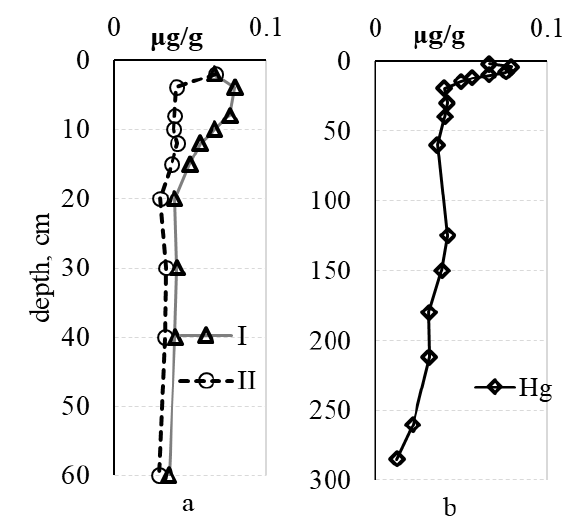
Figure 4. Distribution of mercury: ( a ) in the first (I) and second (II) type of the Lake Onego bottom sediments, ( b ) the average concentration in the Lake Onego bottom sediments.